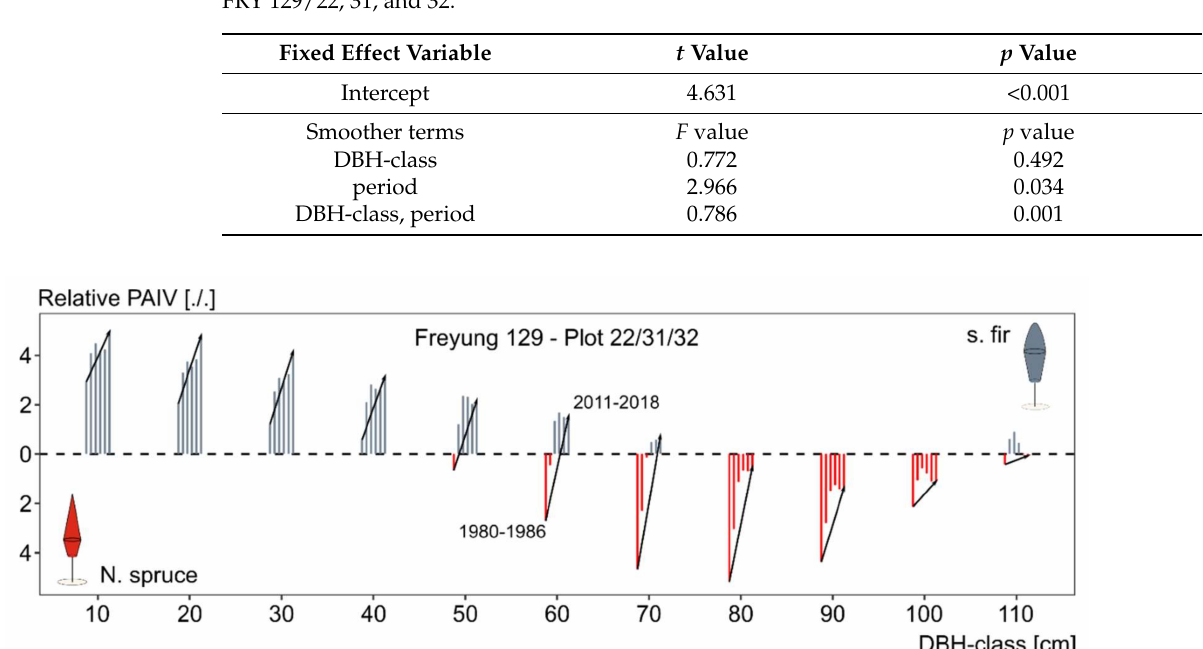
Figure 7. A comparative plot of the relative annual periodic volume increment (RPAIV) between the tree species Norway spruce (red) and silver fir (grey) modeled according to Equation (9). Bars within a DBH-class represent, from left to right, (y intercept = 0) show that s. fir had a higher share of volume growth in the respective DBH-class and observation period. Red bars below the dashed line indicate that N. spruce had a comparatively higher share. Black arrows show the trend in RPAIV between the first observation period (1980–1986) and the last period